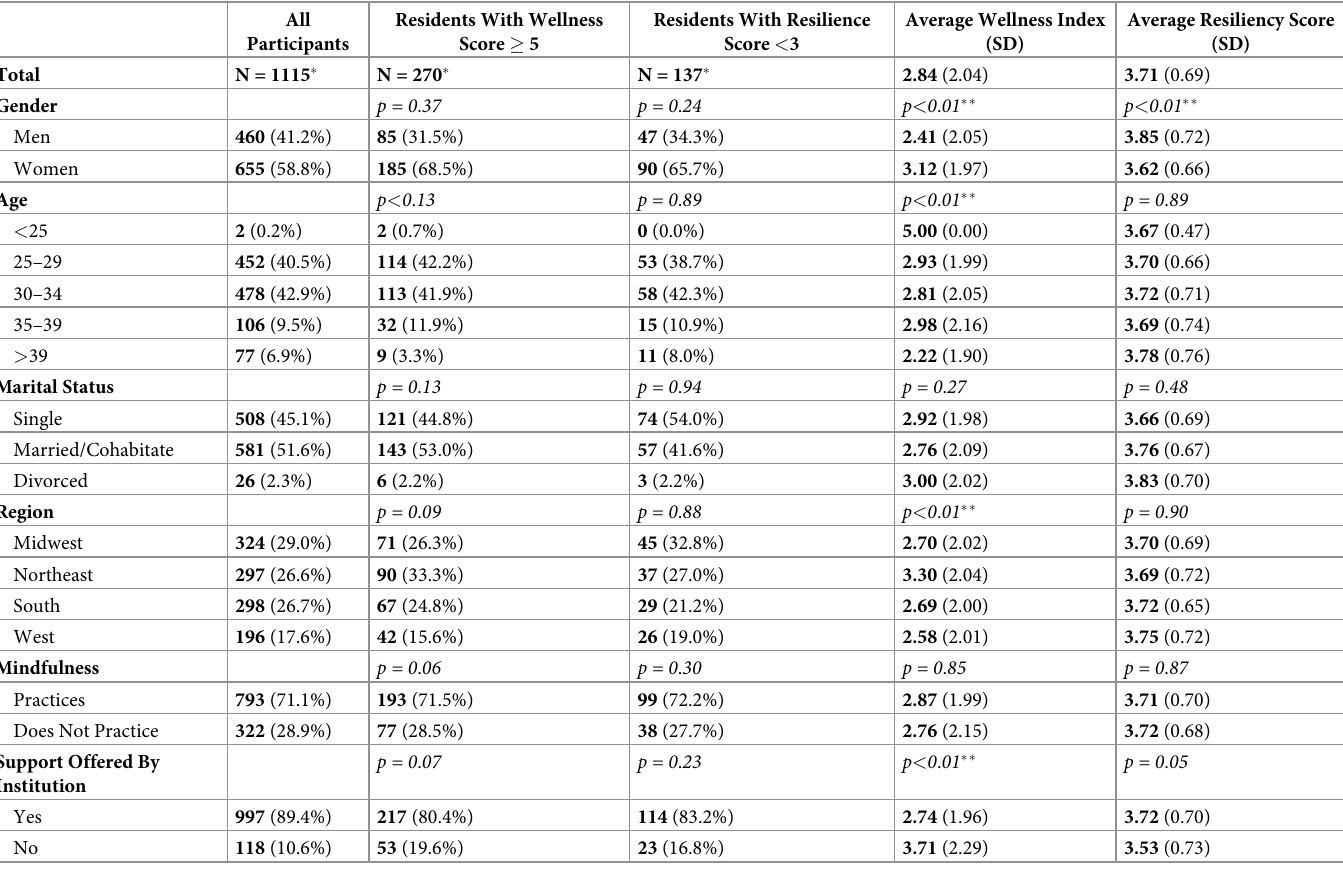
Table 1. Population scores for wellness and resilience (SD = standard